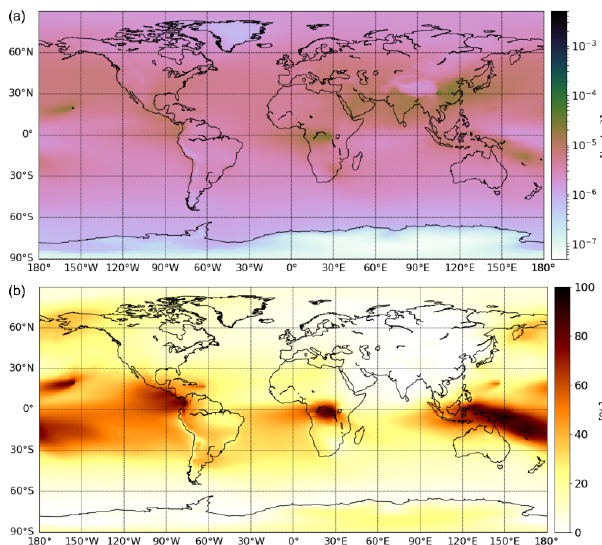
Figure 11. (a) The 2013 annual mean sulfate tropospheric column from CARNALTI (in kilograms per square meter) and (b) its con- tribution due to volcanic emissions (in percent).